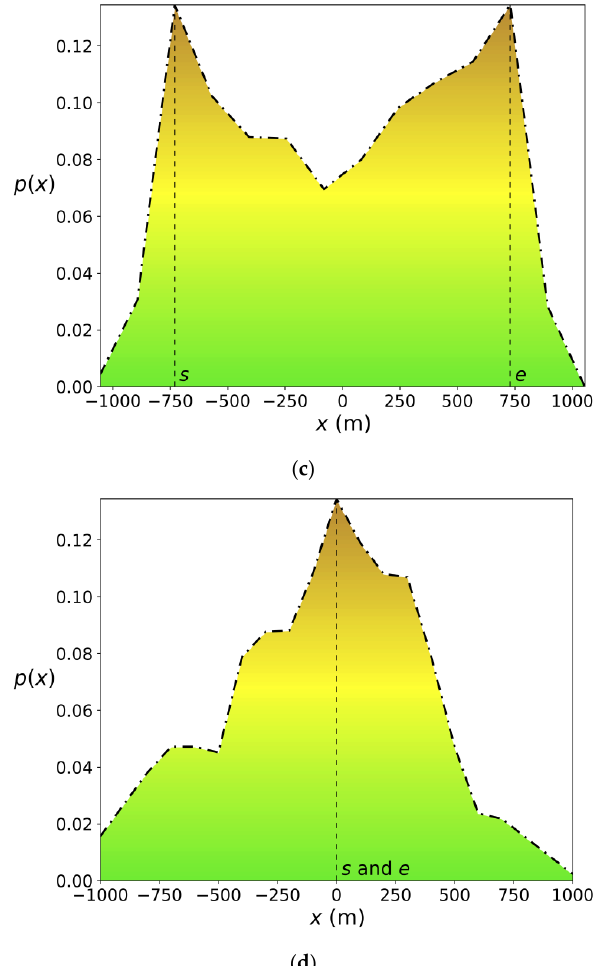
ISPRS Int. J. Geo-Inf. 2022 , 11 , x FOR PEER REVIEW Figure 10. Empirical model on PNA: ( a ) discrete type; ( b ) continuous type; ( c ) front view; ( d ) side Figure 10. Empirical model on PNA: ( a ) discrete type; ( b ) continuous type; ( c ) front view; ( d ) side view. view. In addition to the above-mentioned overall perspective, the PNA kernel function can also be tested from a single perspective of the path. Figure 11 shows the three distributions green, and blue paths in Figure 10a. In terms of cost, the red line is the smallest and the the empirical model than the “ ridge ” model: the red line of the two-tuple < R 2 between the proposed model and the empirical model, R 2 between the “ ridge ” model and the empirical model> is <0.718, − 0.531>; the green line, <0.927, 0.624>; and the blue line, <0.842, 0.454>. the “ peak ” .